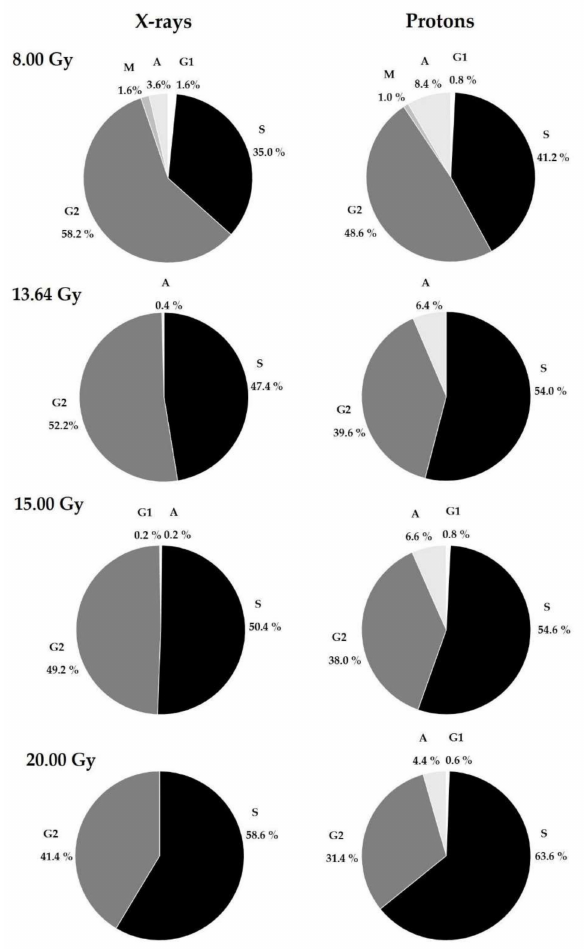
Figure 5. Percentages of cells in the G1, S, G2, M, and A phases at each dose for 10 donors after X-rays and protons in PHA-stimulated HPBLs during exposure at various doses: 8.00, 13.64, 15.00, and 20.00